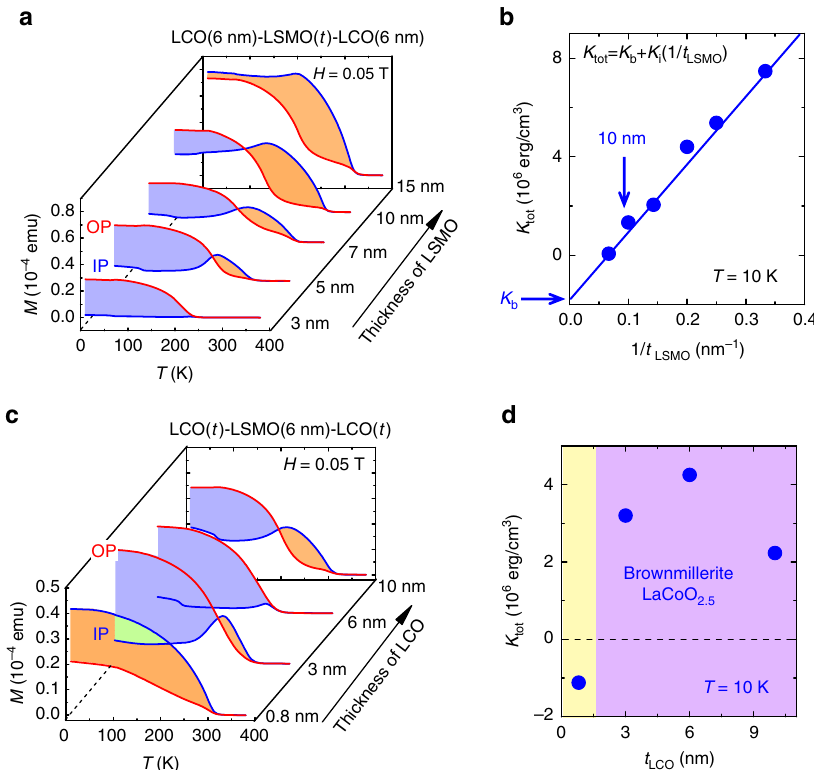
Fig. 4 Effects of layer thickness on magnetic behaviors for LCO/LSMO/LCO trilayers. a Thermomagnetic curves of the LCO(6 nm)/LSMO( t LSMO )/LCO(6 nm) trilayers, collected in fi eld-cooling mode with an in-plane (IP) and an out-of-plane (OP) applied fi eld of 0.05 T, respectively; here, t LSMO takes a value between 3 and 15 nm. Shaded area corresponds to the energy required to orientate magnetic moment to hard axis. b Magnetic anisotropy energy as a function the layer thickness of LSMO. The linear K tot – 1/ t LSMO relation is a fi ngerprint of interfacial effect, where K tot is decomposed into K b and K i , corresponding to the bulk and interface contributions, respectively. c The same as a , except for samples that are now LCO( t LCO )/LSMO(6 nm)/LCO( t LCO ) with a t LCO ranging from 0.8 to 10 nm. d Magnetic anisotropy energy as a function of the layer thickness of LCO. Here, the data at 10 K were presented, simply because our measuring system is most easily thermally stabilized at this